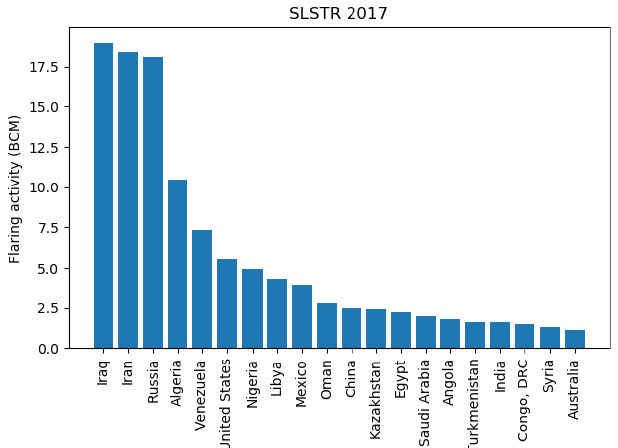
Figure 15. Flaring BC emissions (best estimate, Ggyr − 1 ) by coun- try (top